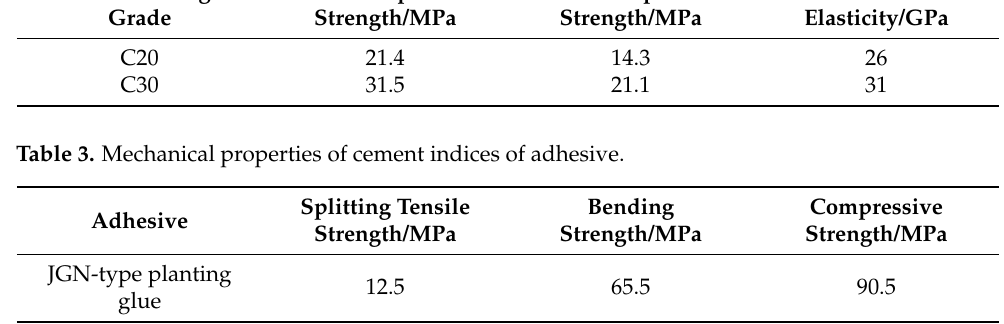
90.5 Table 4. FRP muscle mechanical performance indices of FRPs.